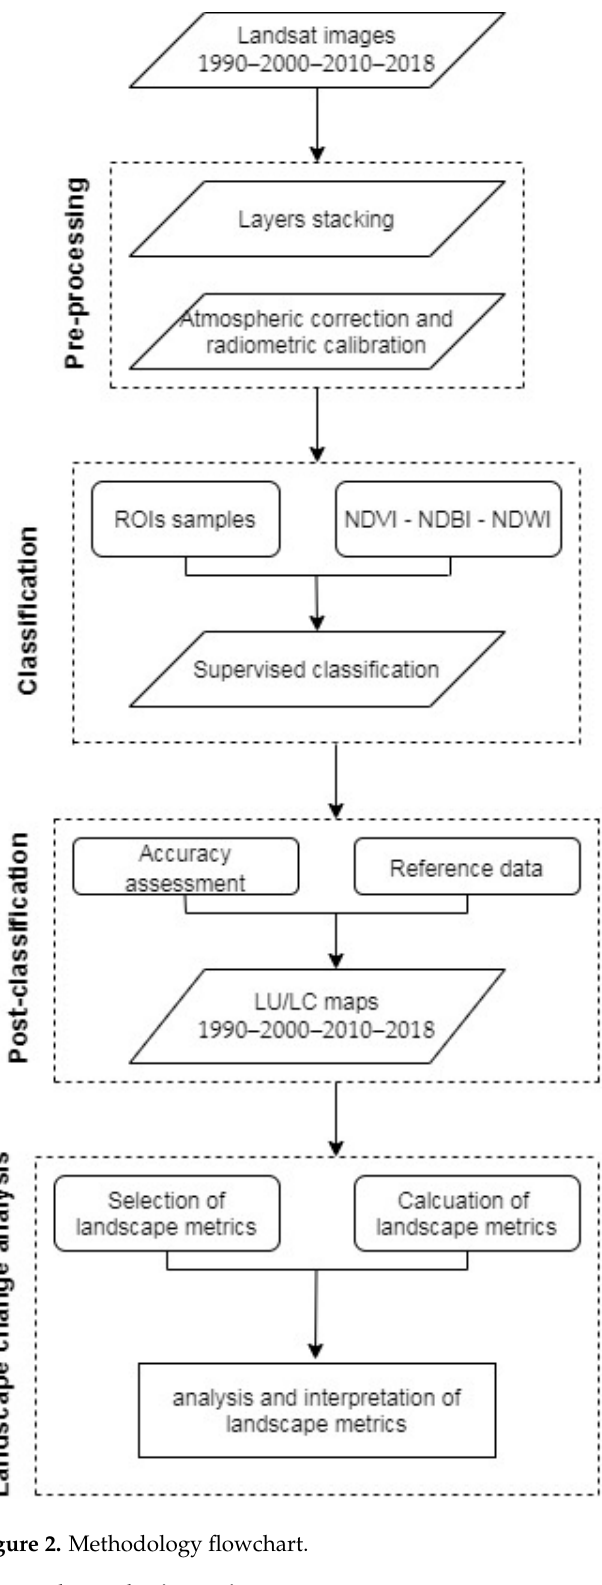
Figure 2. Methodology flowchart.